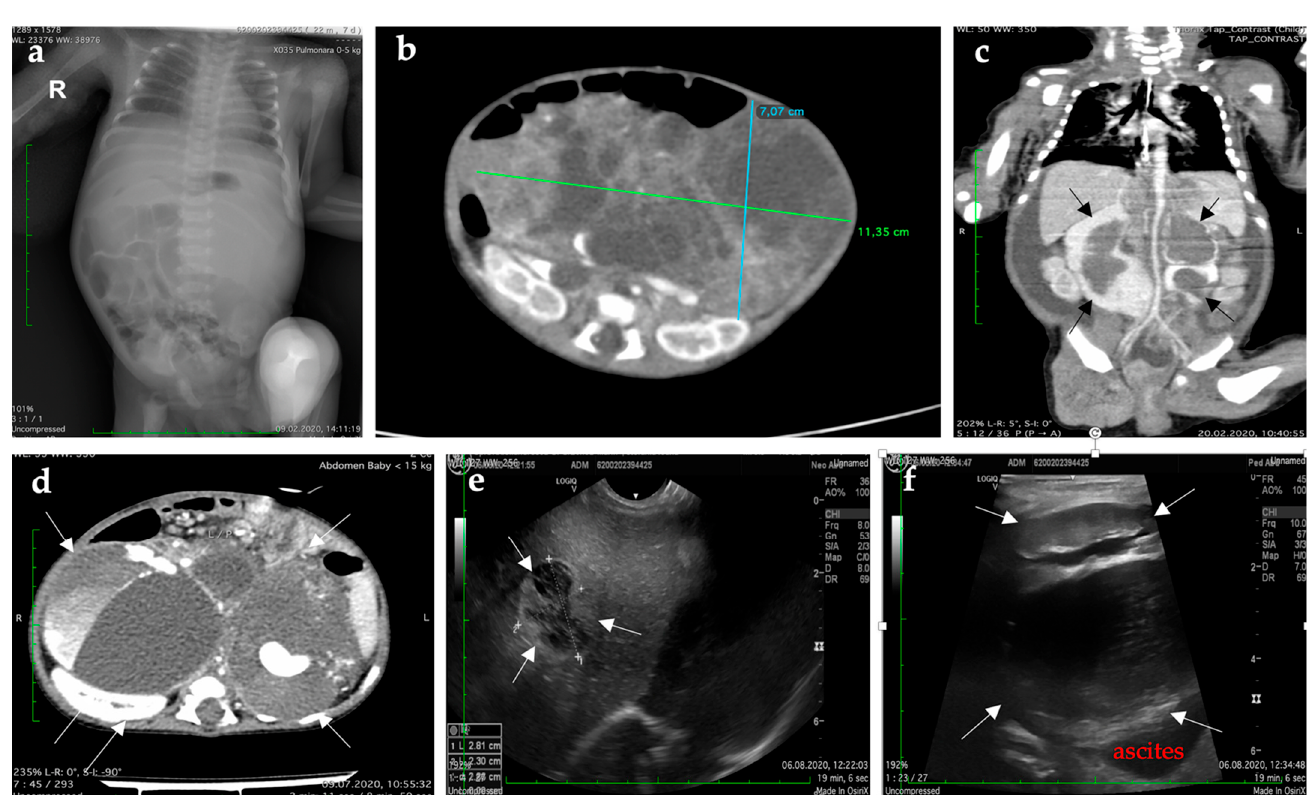
Figure 2. Postnatal imagistic findings. ( a ) Initial preoperative radiological evaluation showing ascension of the diaphragm due to pancreatic tumor mass. ( b ) Preoperative CT scan reveals a large mass in the fetal pancreas. ( c ) Postoperative CT scan showed residual tumor. ( d ) CT scan reveals multiple hepatic tumors with cystic components (arrows). ( e ) Ultrasonography showed liver relatively homogeneous with a nodular image of 23 mm with mixed appearance, predominantly transonic in segment VII. ( f ) Ultrasonography revealed multiple hepatic tumors with cystic components (arrows).